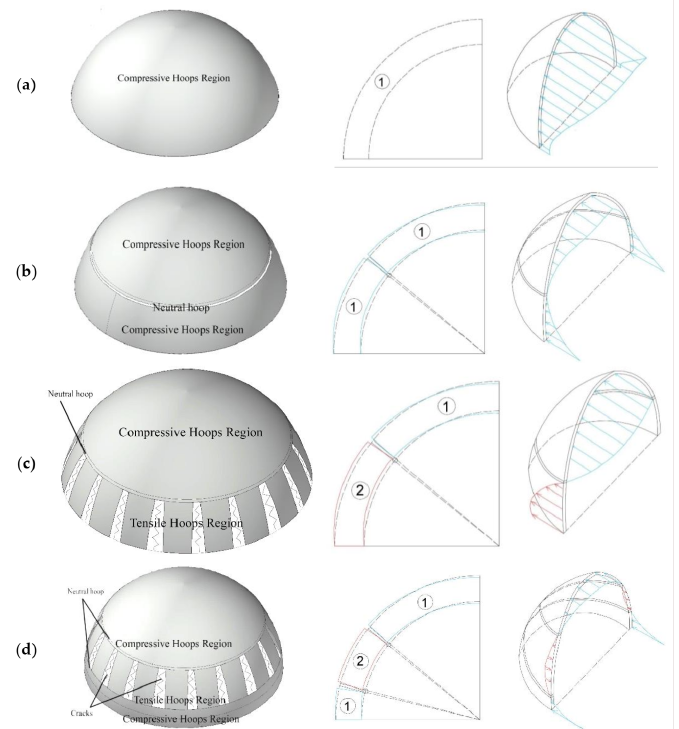
Figure 6. Definition of masonry dome behavior based on the Eddy and L é vy method. ( a ) Single- masonry dome; ( b ) double-masonry dome behavior; ( c ) double-masonry dome; ( d ) treble-masonry dome behavior. Region 1 is compressive, and Region 2 is